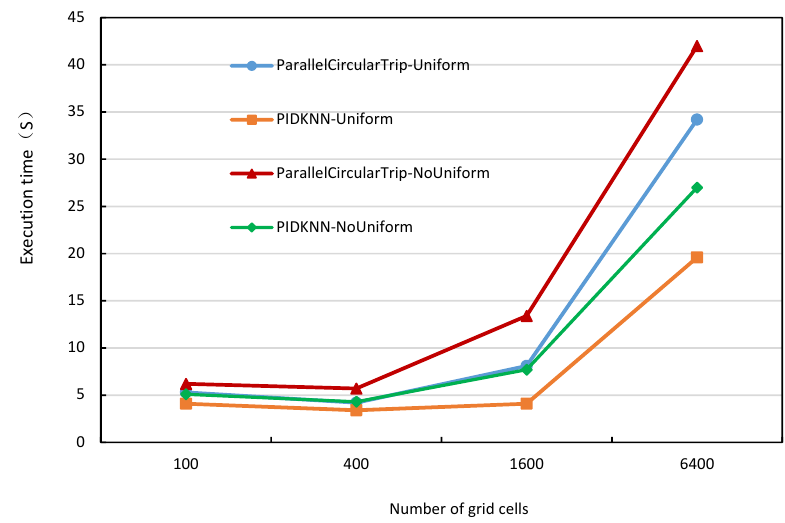
Figure 7. Execution time vs. number of grid cells.